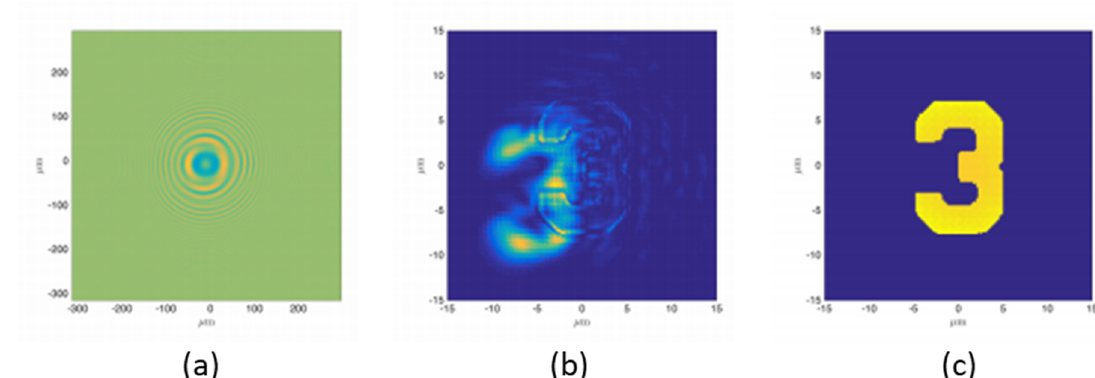
Figure 14. ( a ) Simulated hologram. ( b ) Reconstruction obtained using the general (planar waves) algorithm assuming no aberrations on the reference beam while in ( c ), the wavefront information was included in the reconstruction. X and Y axis are in µm. Adapted with permission from [72].